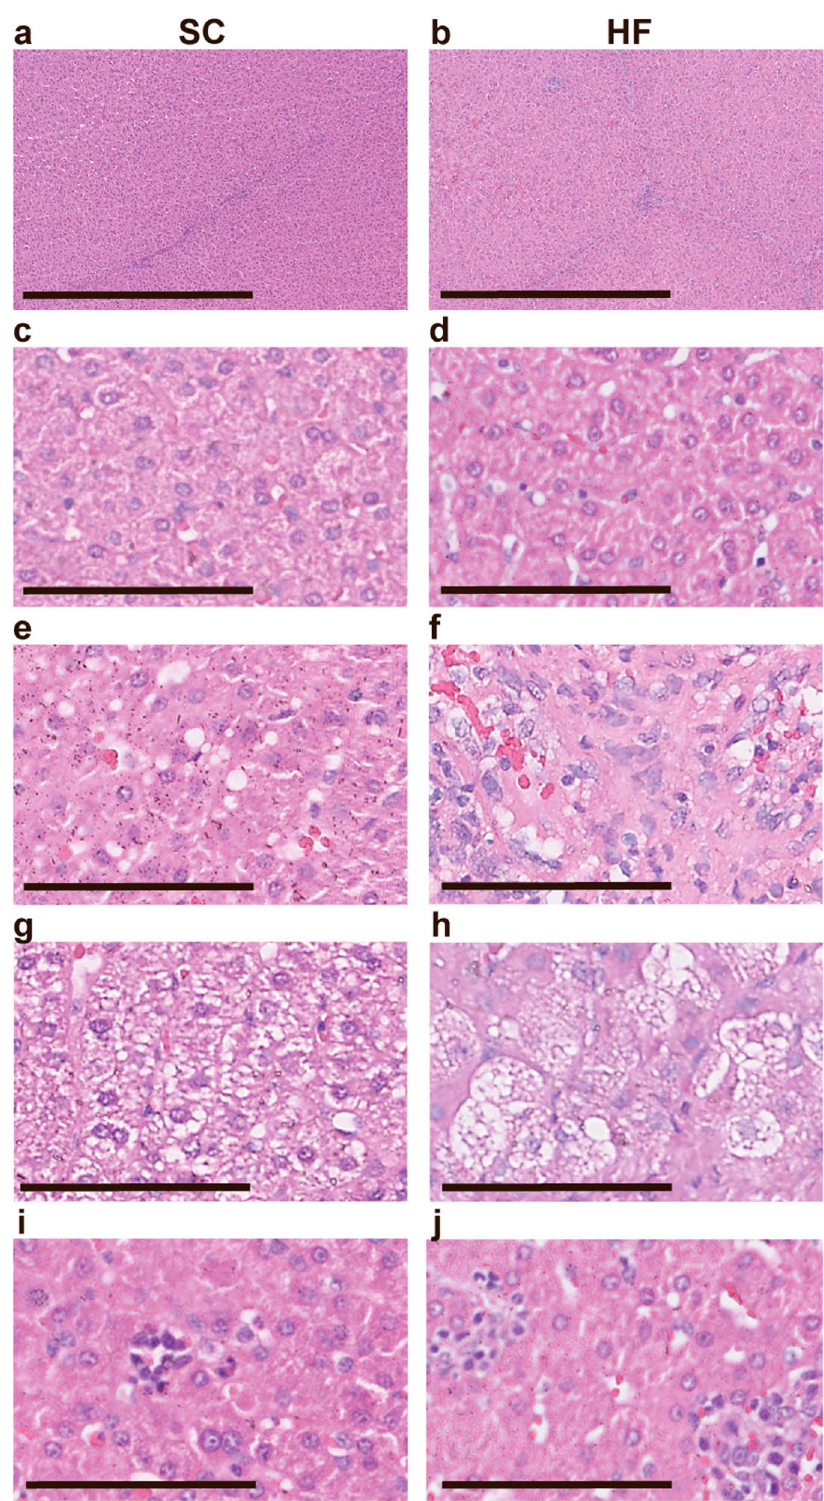
Figure 2. Representative liver HE stainings of pigs on standard chow (left panel, SC) and high-fructose (right panel, HF). Liver histology overall appeared normal ( a – d ) in both groups. Small foci with signs of microvesicular steatosis ( e , f ), hepatocyte ballooning ( g , h ) and inflammatory islets ( i , j ) could be found. Scalebars 800 µm ( a , b ) and 100 µm ( c – j